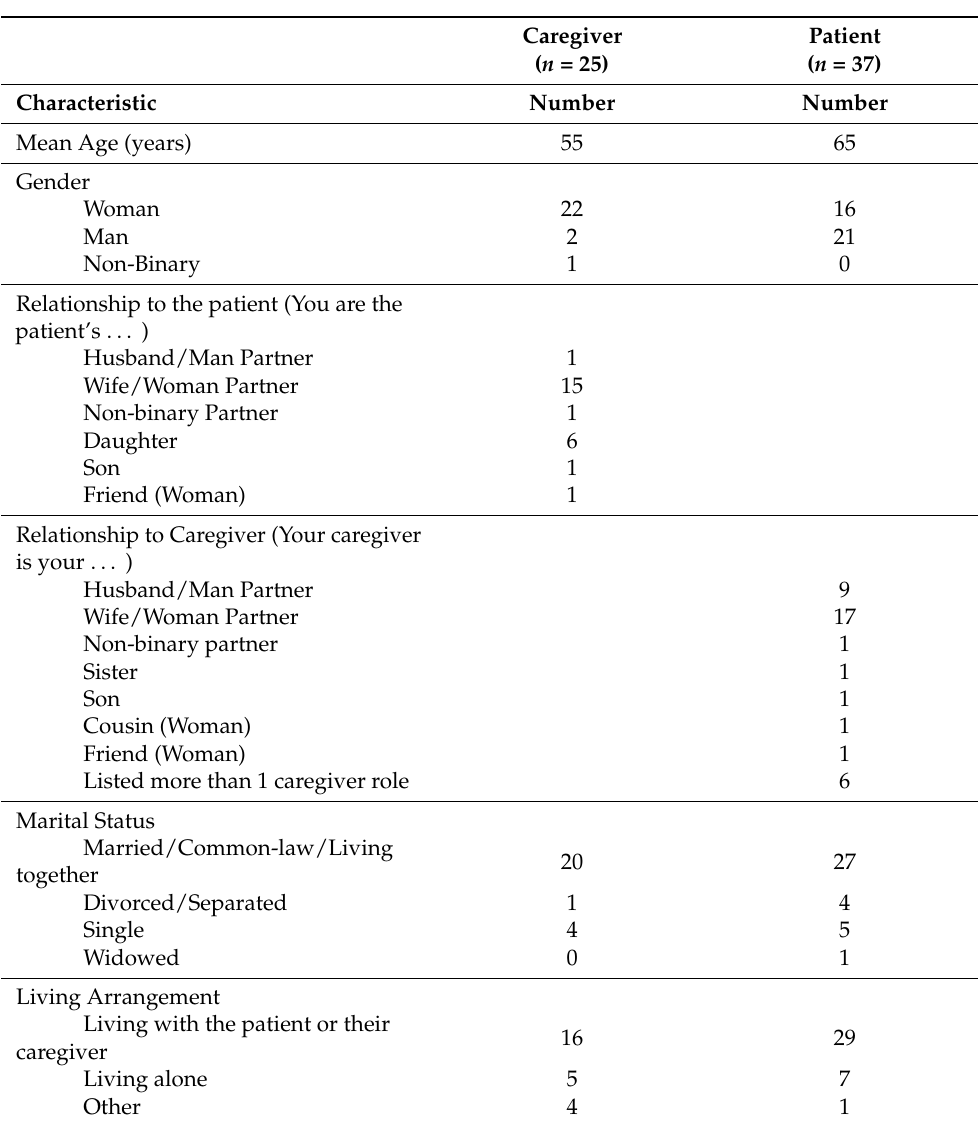
Table 1. Participant Demographic